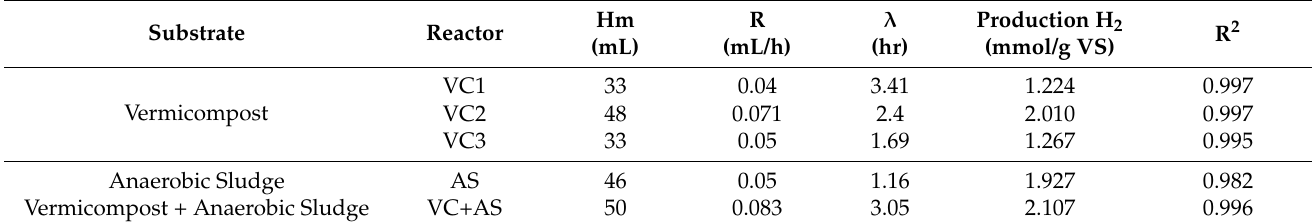
Table 2. Estimated parameters of Gompertz equation for Biohydrogen Production.